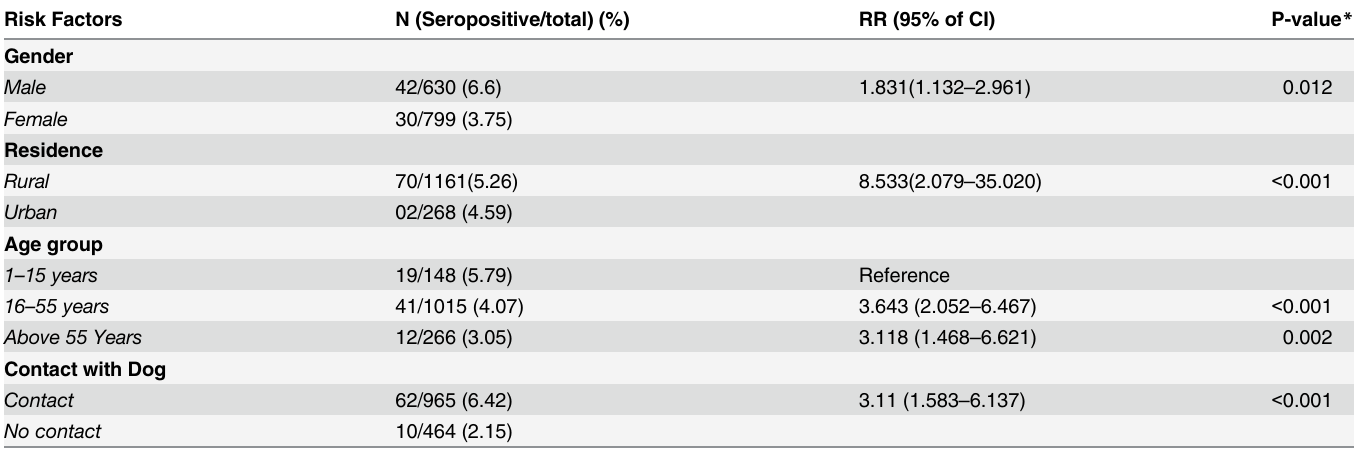
Table 2. Association of potential exposure variables with seroprevalence of hydatid infection as determined by univariate analysis. Risk